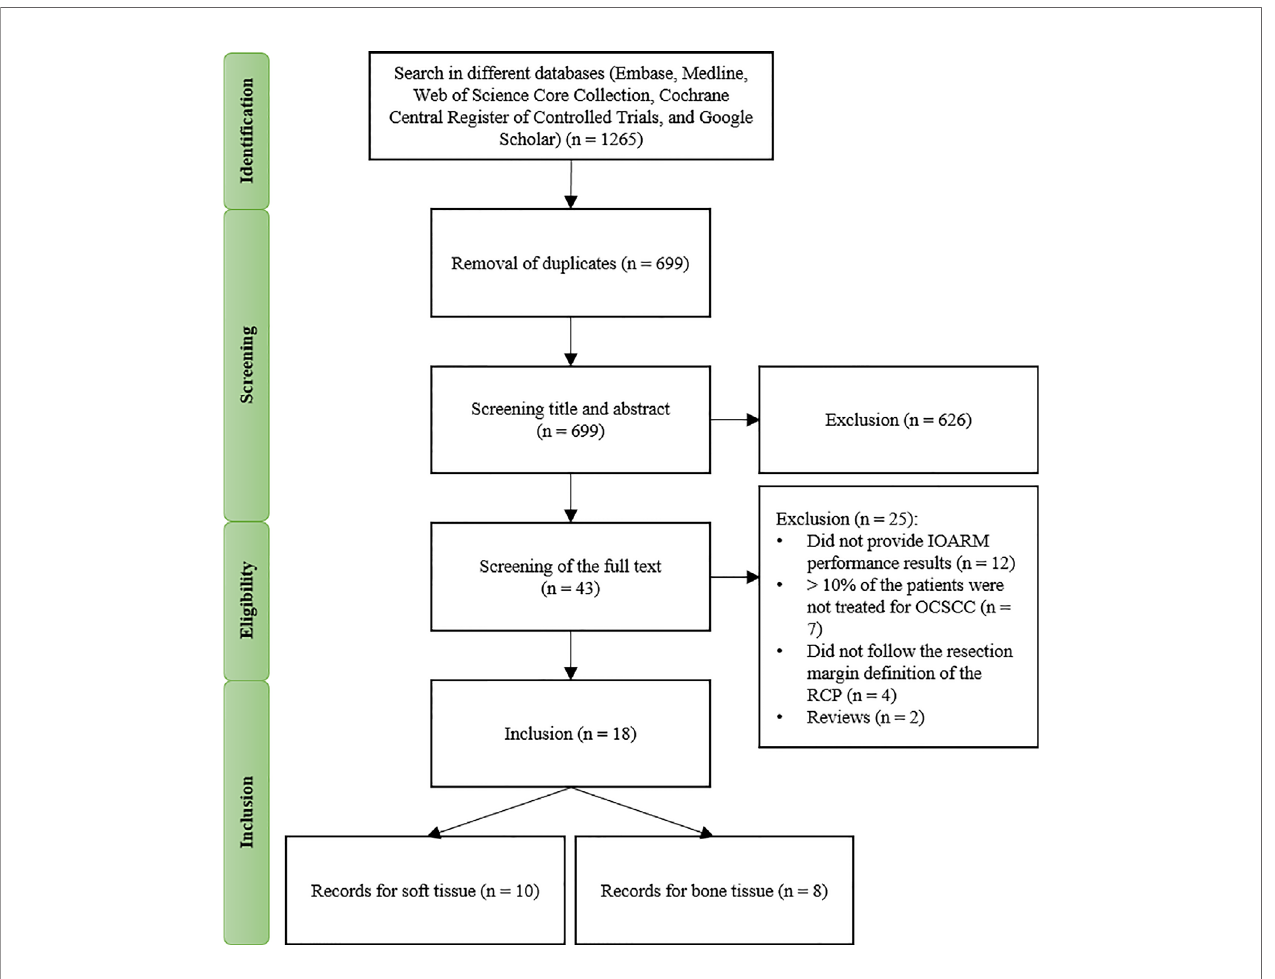
FIGURE 1 | Flow diagram of the study selection